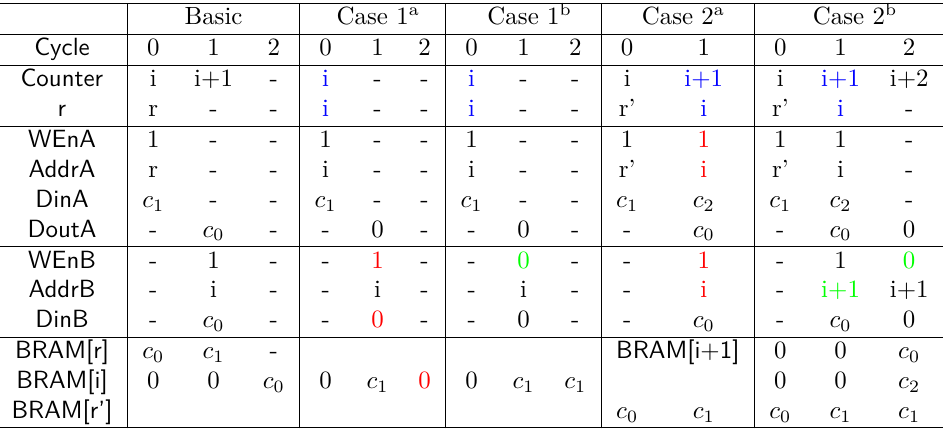
Figure 10: Structure of the SampleInBall module. The black, blue, and red components are used for processing in the basic case, the first special case, and the second special case, respectively. Table 2: Timing diagram of the SampleInBall module in various